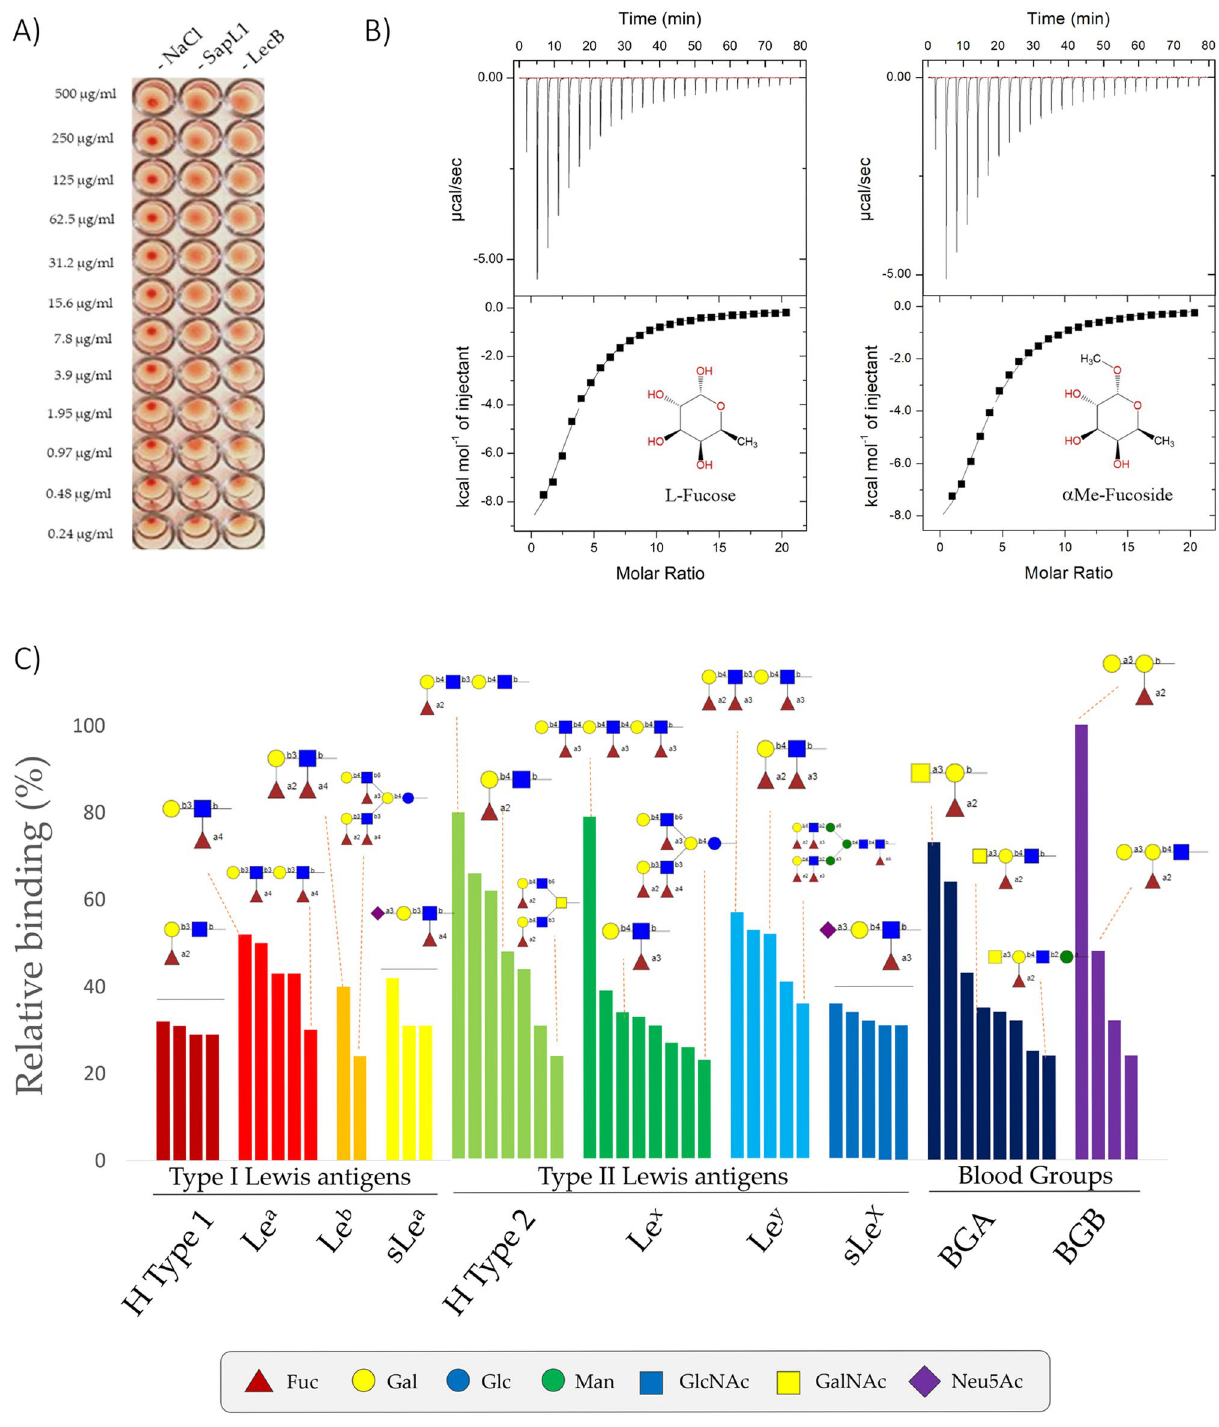
Figure 3. SapL1 carbohydrate binding properties. ( A ) Hemagglutination assay of SapL1 on fresh rabbit erythrocytes. Negative and positive controls consist of 150 mM NaCl and the lectin LecB from Pseudomonas aeruginosa , respectively. ( B ) Titration of SapL1 with L-fucose and α-methyl-fucoside with the thermogram and the integration displayed at the top and bottom, respectively. ( C ) Analysis of the interactions of SapL1 with blood group epitopes. The graph shows the relative binding of SapL1 to glycans containing Lewis and ABH blood group antigens from the 90 hits identified as